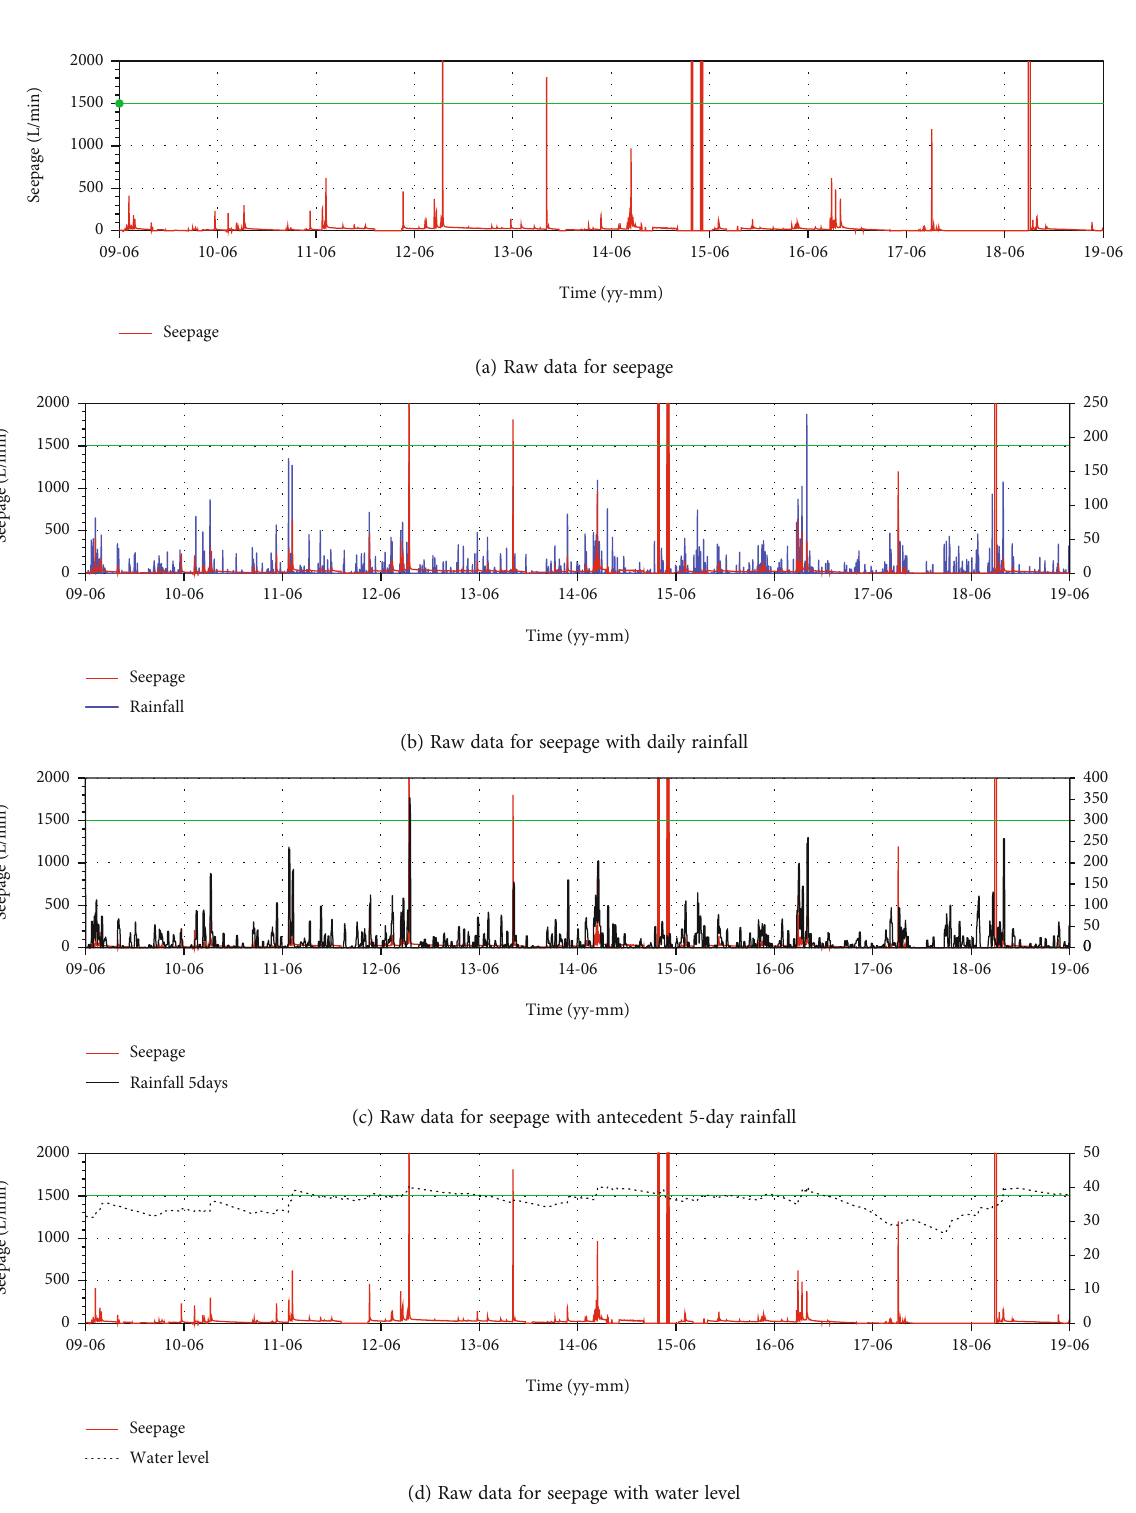
Figure 7: Comparisons among seepage, rainfall, and water